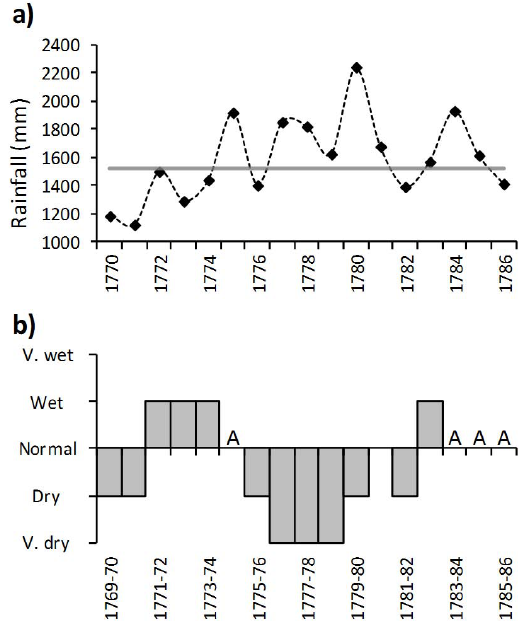
Fig. 6. (a) Annual rainfall totals calculated from daily measure- ments taken at Savanna-la-Mar, western Jamaica, calendar years 1770 to 1786 (after Chenoweth, 2003). Solid grey line represents mean of annual totals, 1761–86. (b) Documentary-derived chronol- ogy of average rainfall conditions throughout Antigua, rain-years 1769–70 to 1785–86. A denotes assumed ‘normal’